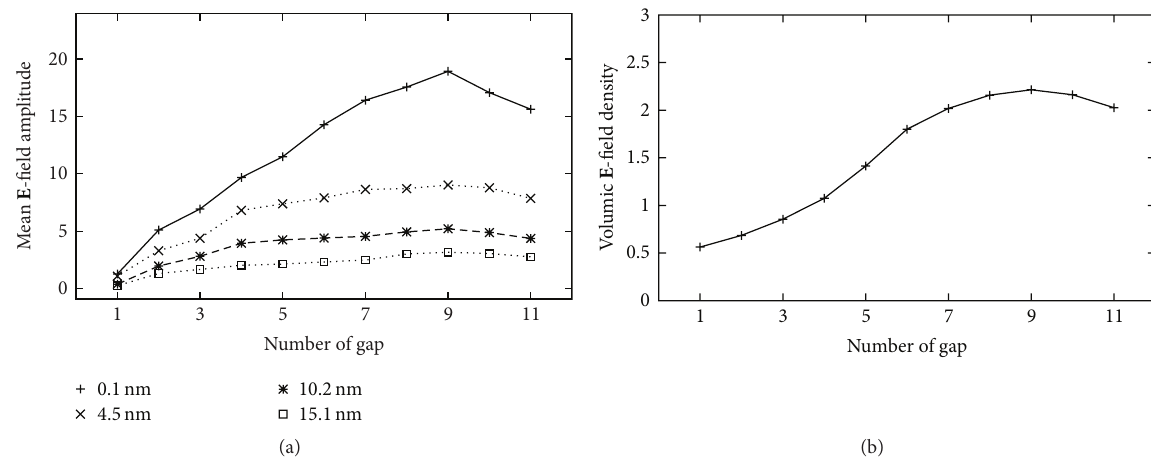
Figure 5: Evolution of (a) the mean electric amplitude as function of the number of gap and for four distance from the glass surface. Evolution of (b) the integrated electric amplitude density per volume as function of the number of gap. A maximum efficiency is reached at nine gaps (i.e., for ten